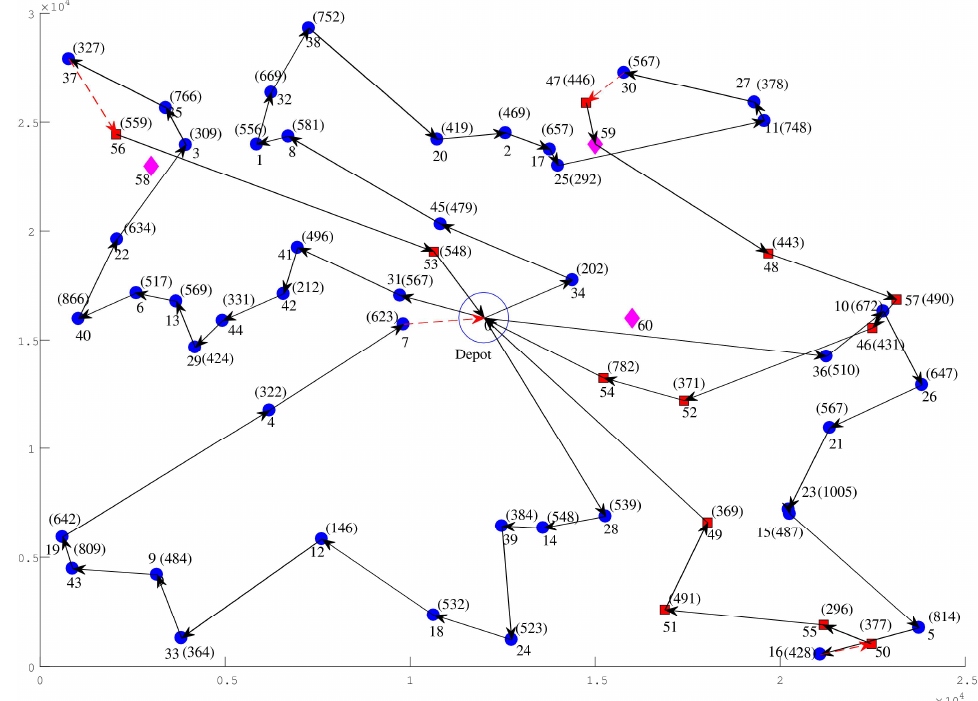
Fig. 6. Optimal solution of the instance G6 found using the MILP-EVRPB with initialization